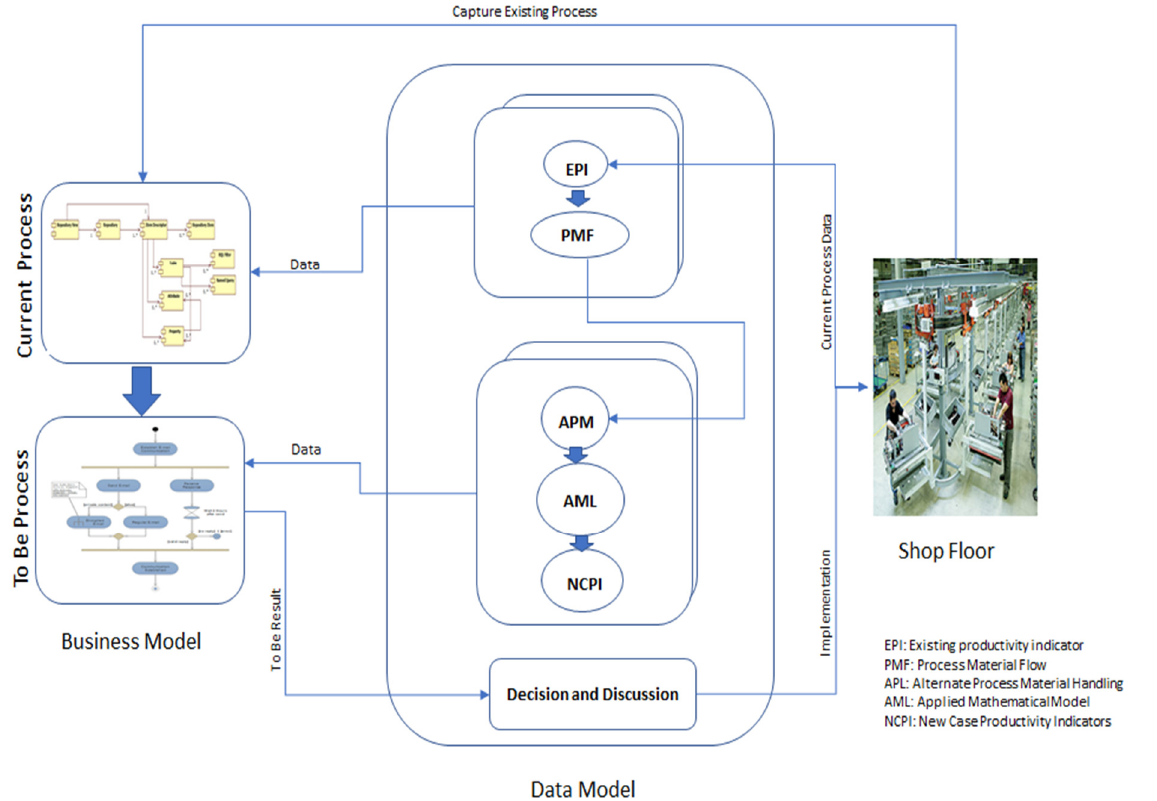
Fig. 1: Framework and research